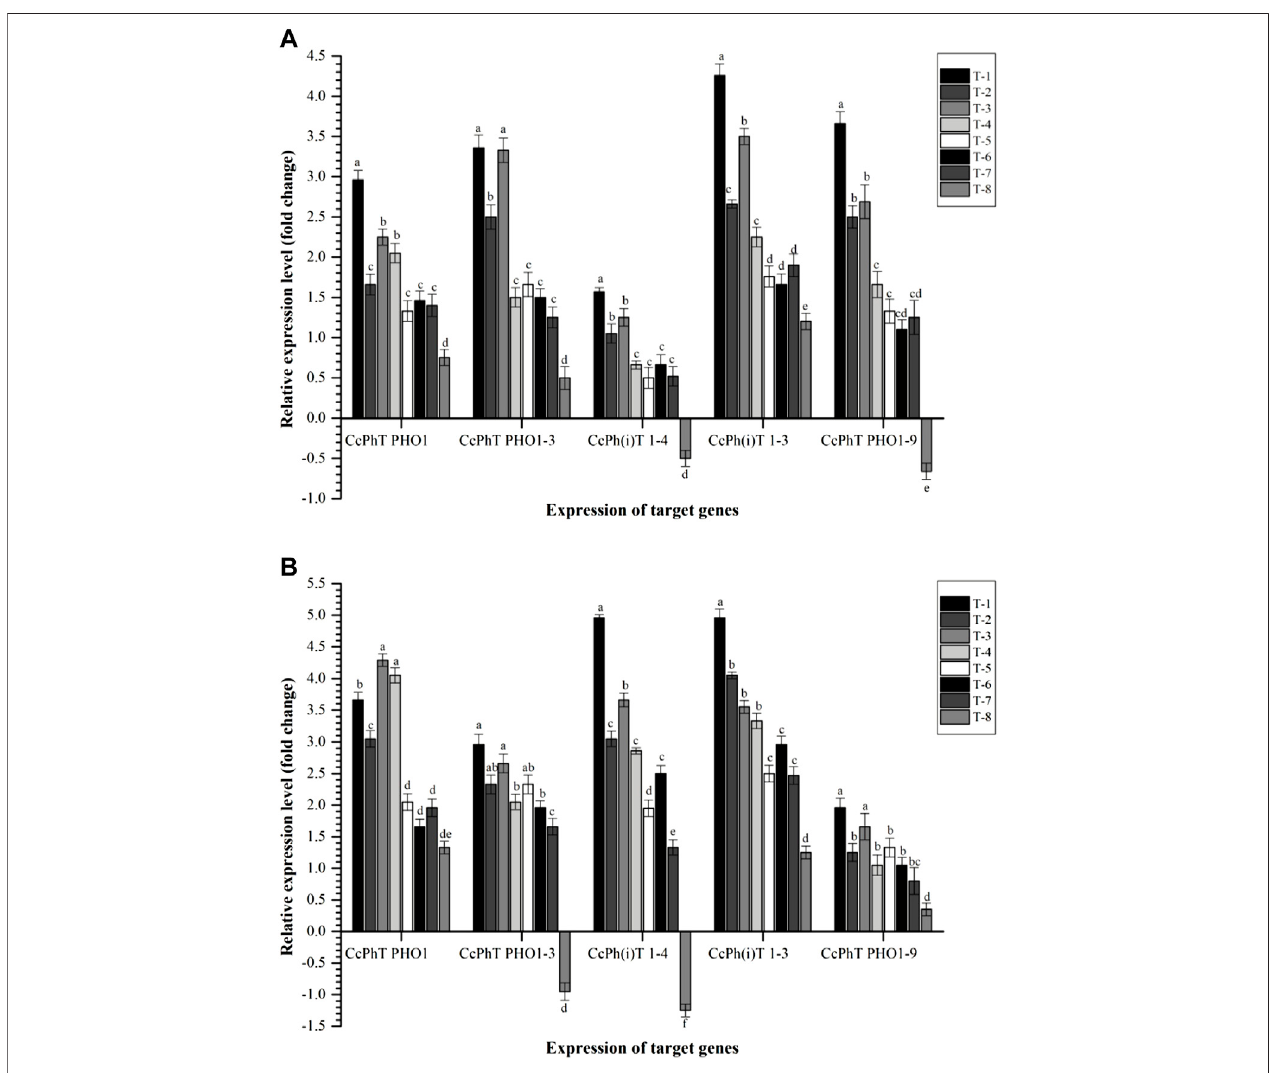
FIGURE 8 | Effects of seed inoculation of SOB on expression of phosphate transporters in the pigeonpea leaves at (A) 30 and (B) 60 days of sowing. Treatments were as follows: T1 — Stenotrophomonas maltophilia DRC-18-7A, T2 — S. maltophilia DRC-18-10, T3 — S. pavanii DRC-18-7B, T4 — S. pavanii DRC-18-11, T5 — R. pusense DRC-18-25, T6 — R. pusense DSC-18-5, T7 — R. pusense DJC-18-21, and T8 — Untreated control (No inoculation). Data are mean ( n = 5) and vertical bar representsthestandarddeviation.Datawithdifferentlettersshowsigni fi cantdifferenceincolumndatainrandomizedblockdesigntestat p < 0.05underDuncan ’ s multiple-range